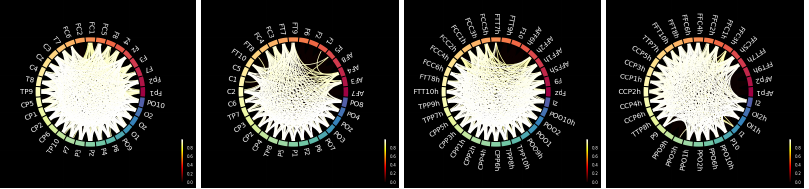
Figure 10. Circular connectivity of the approximated connectivity matrix; from ( left ) to ( right ): green ( Ch 1 − Ch 32 ), yellow ( Ch 33 − Ch 64 ), red ( Ch 65 − Ch 96 ), white ( Ch 96 − Ch 128 ) labeled electrodes according to actiCAP128 standard-2, described in Figure